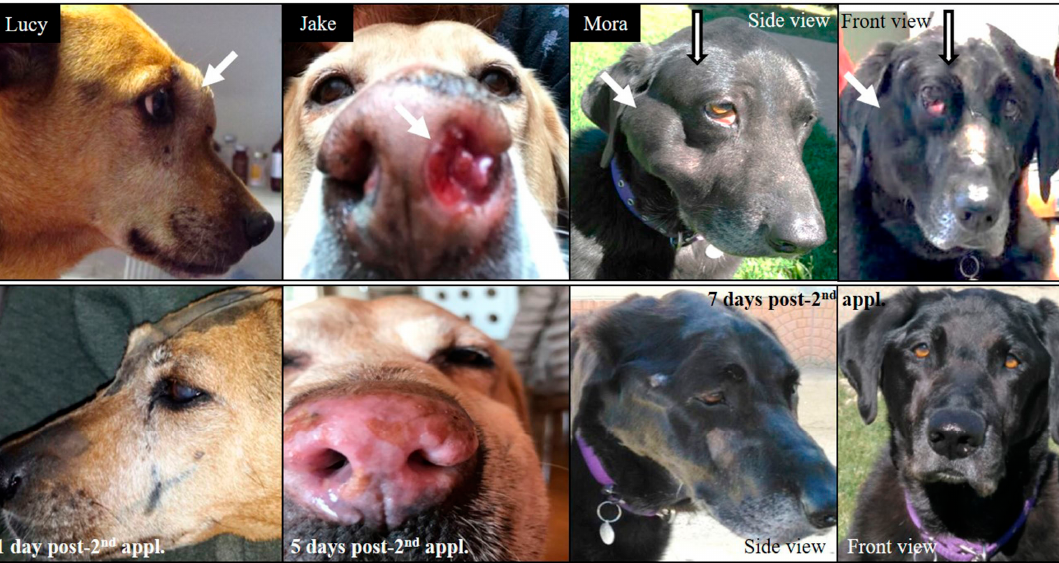
Figure 3. Patients pre-BNCT (top panel) and post BNCT (lower panel).